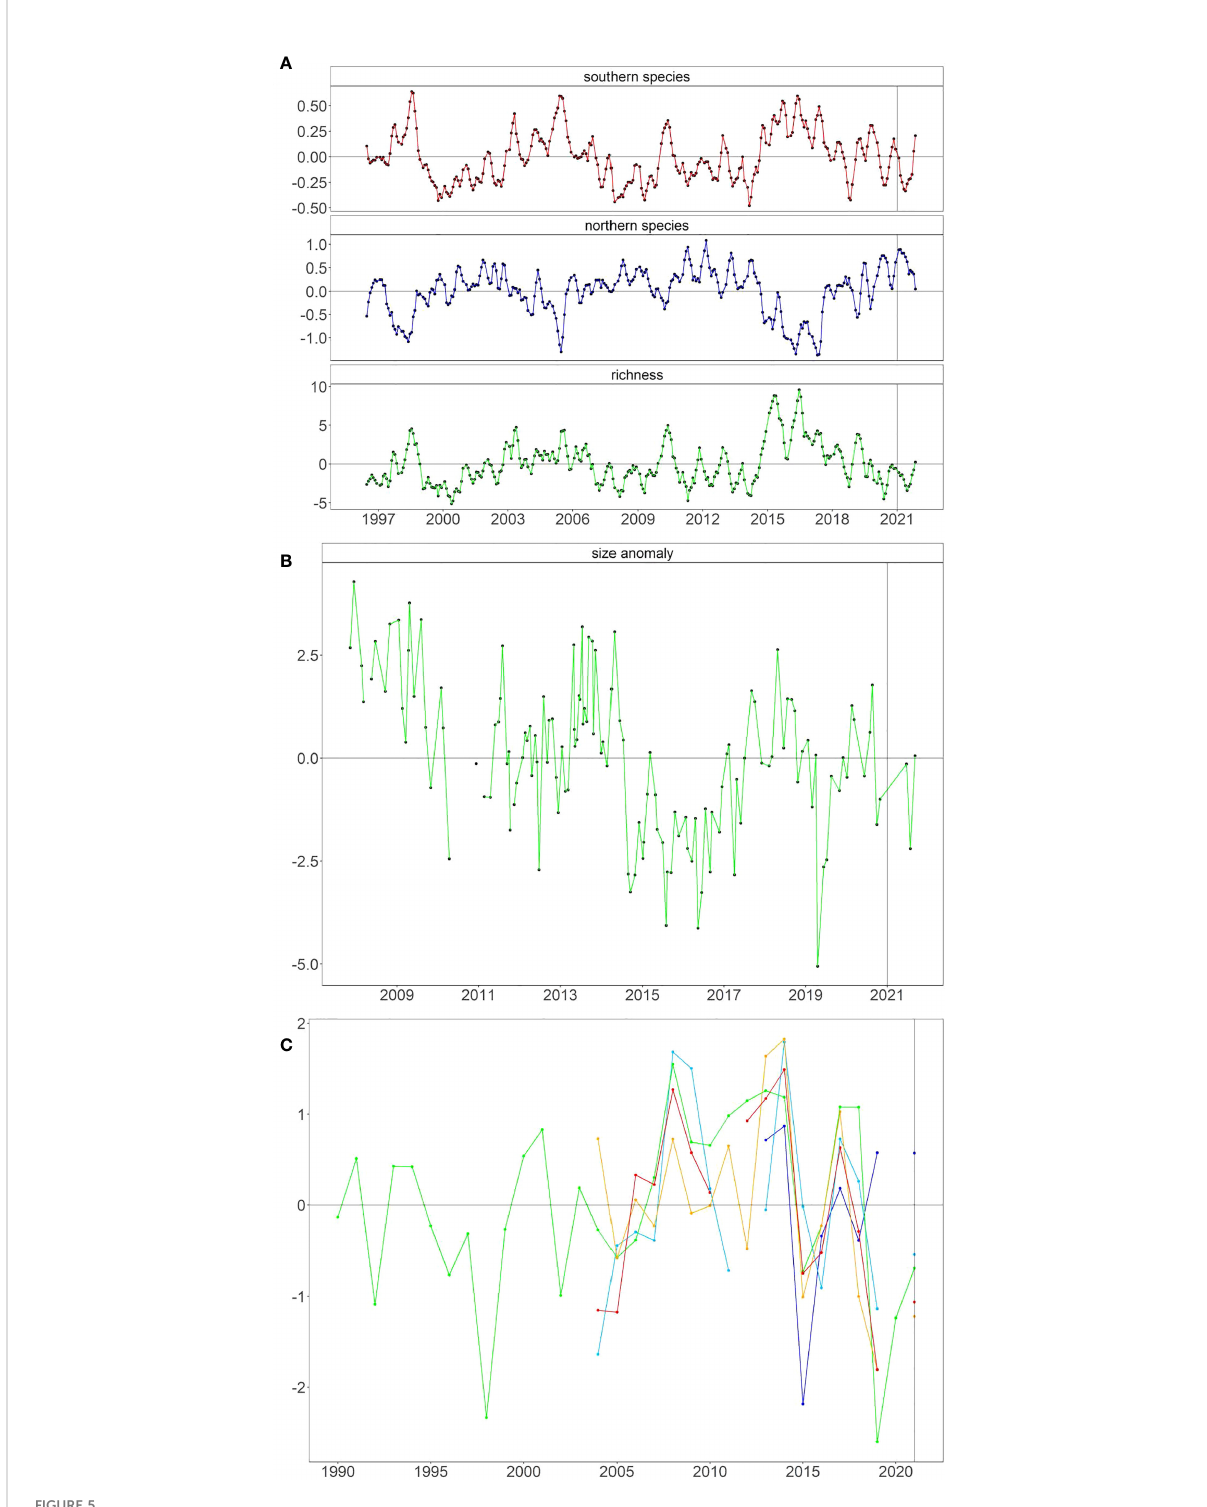
FIGURE 5 Seasonally adjusted anomalies of planktonic invertebrates from (A) Newport Hydrographic Line off Oregon, (B) Euphausia paci fi ca from Trinidad Head Line off northern California, and (C) total abundance of krill from the Rock fi sh Recruitment and Ecosystem Assessment Survey off various parts of